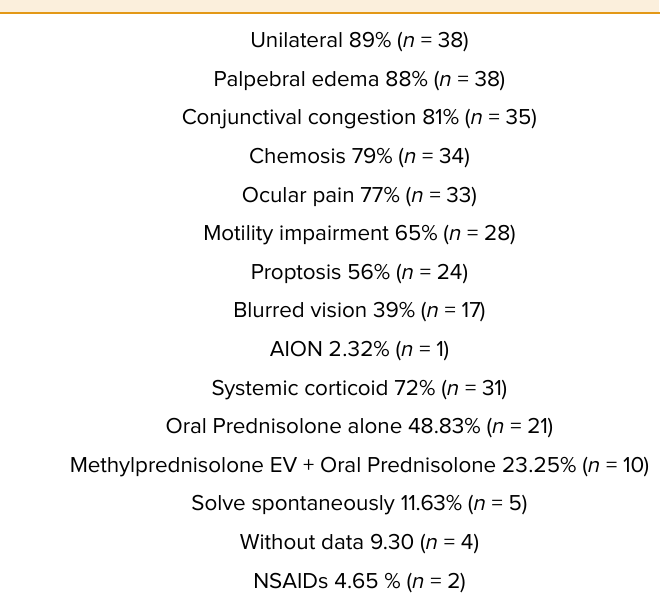
Table 2. Clinical presentation and